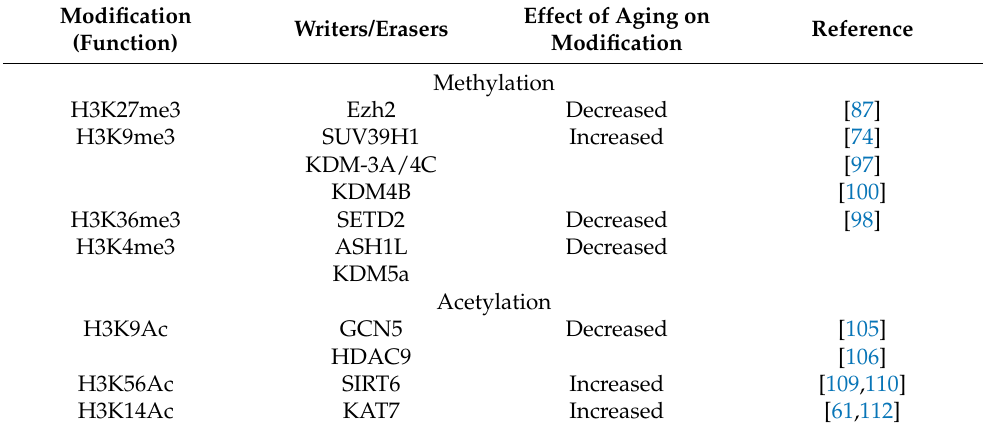
Table 2. Summary of the key histone modifications related to function and abundance in aging MSC.